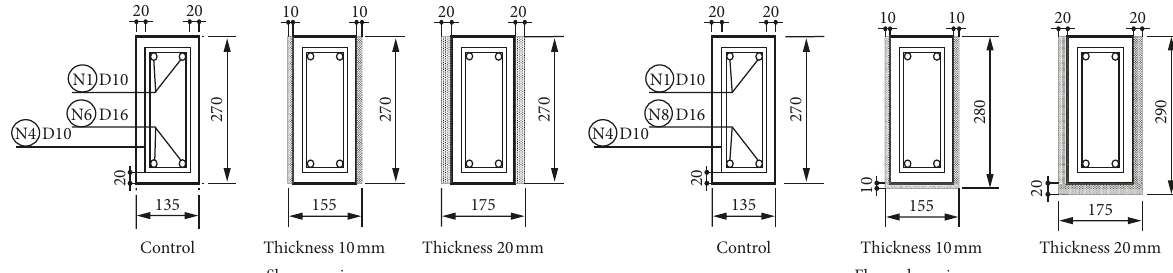
Figure 6: Section of NSC beams jacketed with UHPC.